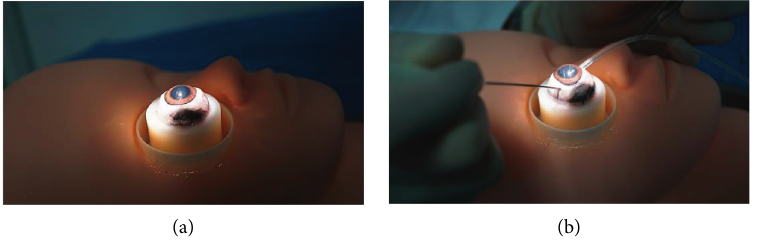
Figure 1: Steps of the vitreoretinal surgery. (a) Fix the porcine eye at the eye seat model. (b) Two incisions were made at the location of 4 o’clock and 10 o’clock, 2 millimeters away from the corneal limbus, with a 25-gauge needle and the probe of endoscope entering the